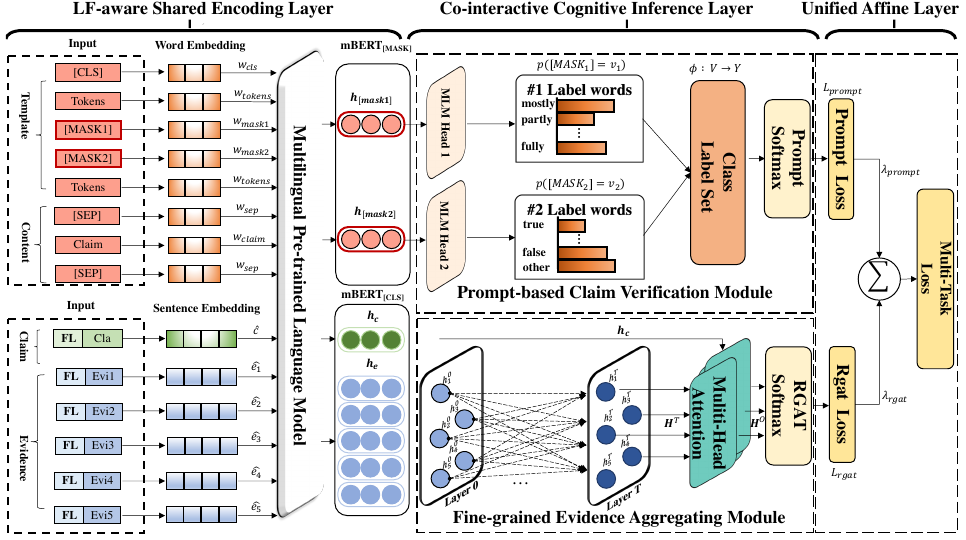
Figure 2. The architecture of the PEINet model consists of three components. The input is a claim and pieces of evidence, and the output is the distribution probability of